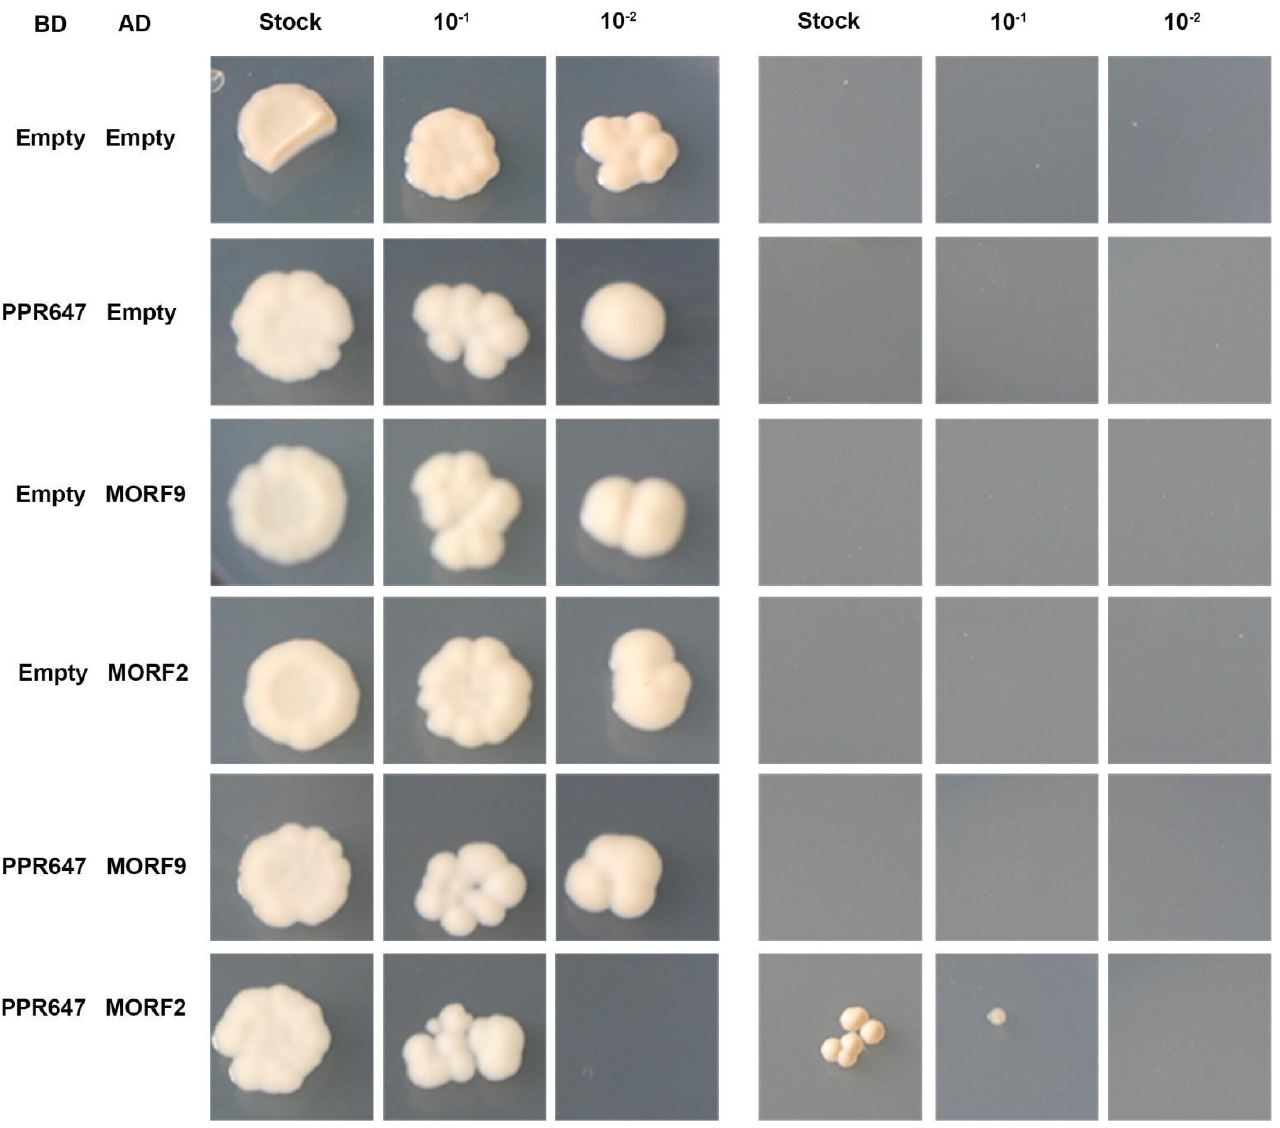
Figure 9. The interaction between PPR647 and MORF2 protein. Yeast two−hybrid assays indicated the interactions between PPR647 and MORF2. Proteins were obtained on the selective medium SD−Trp−Leu and SD−Trp−Leu−His−Ade. AD, activating domain; BD, binding domain.